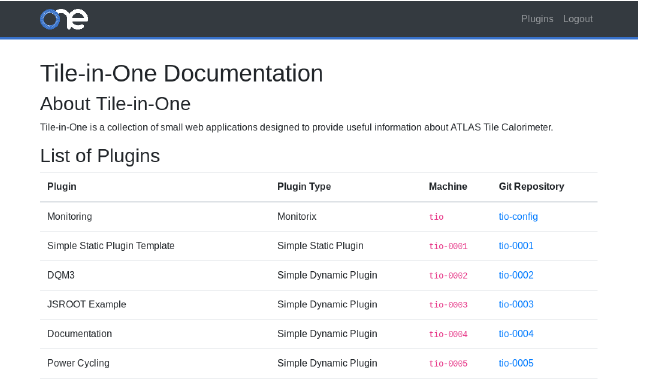
Figure 7. Screenshot of a TiO platform complementing plugin, which serves